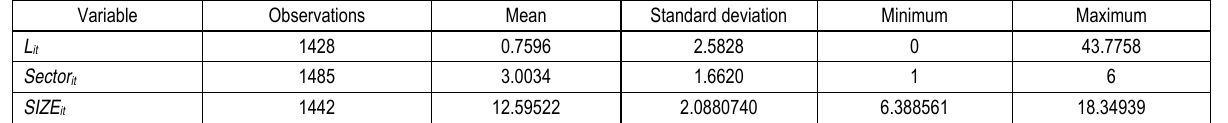
Table 6. Descriptive statistics, Model III